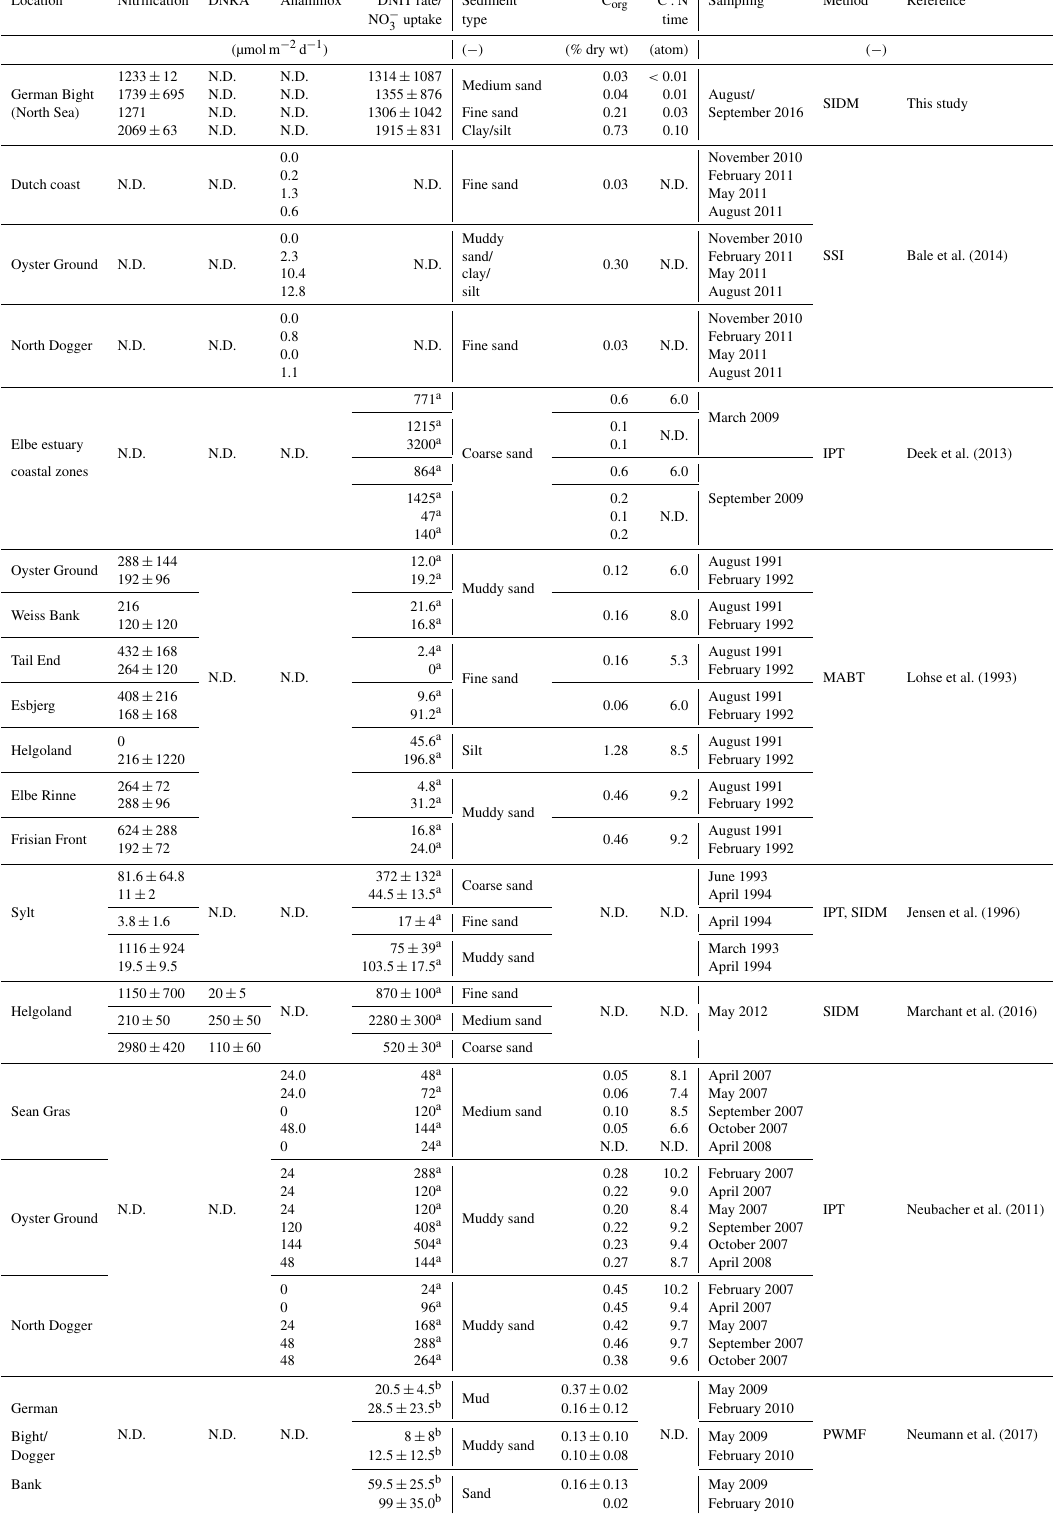
Table 1. Rates of nitrification, dissimilatory nitrogen reduction to ammonia (DNRA), anaerobic ammonia oxidation (anammox) and denitri- fication (DNIT) (in µmolNm − 2 d − 1 ) in the North Sea of other published